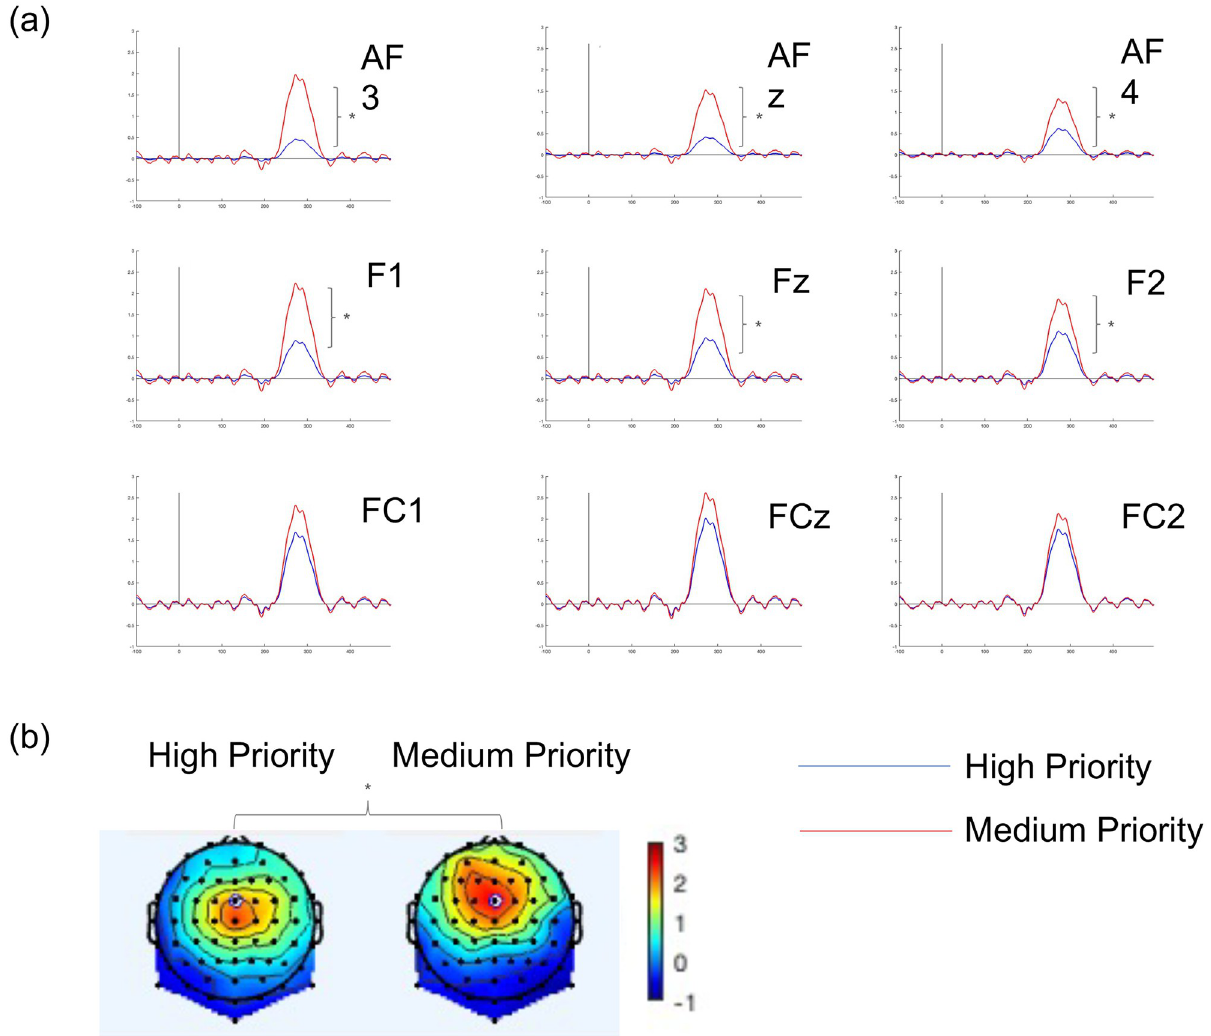
Fig 8. (a) P3a (TF04) waves for high priority (blue lines) and medium priority (red lines) pulses of the Antero-Frontal, Frontal and Fronto-Central regions; and (b) voltage topographical distributions to the peak of the P3a (273 ms) in response to the High priority and Medium priority pulses ( �� p <